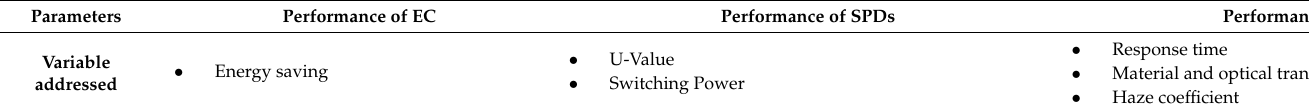
Table 2. Performance of smart glazing types according to climatic